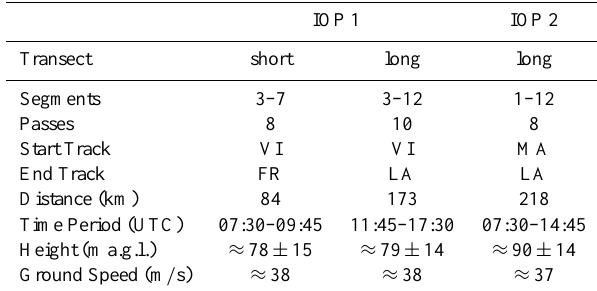
Performed measurement flights during IOP1